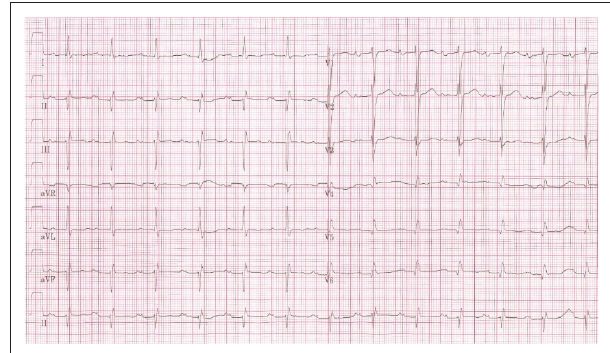
FIGURE 4: Electrocardiogram (ECG) of patient.